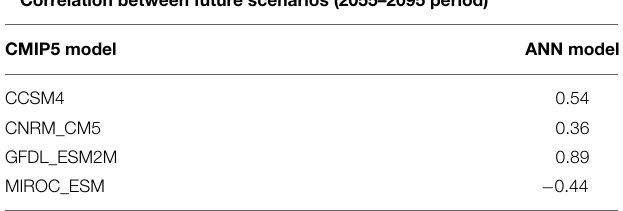
TABLE 4 | Correlation between the future scenarios for the 2055–2095 period projected direct from the CMIP5 models and indirect from the ANN